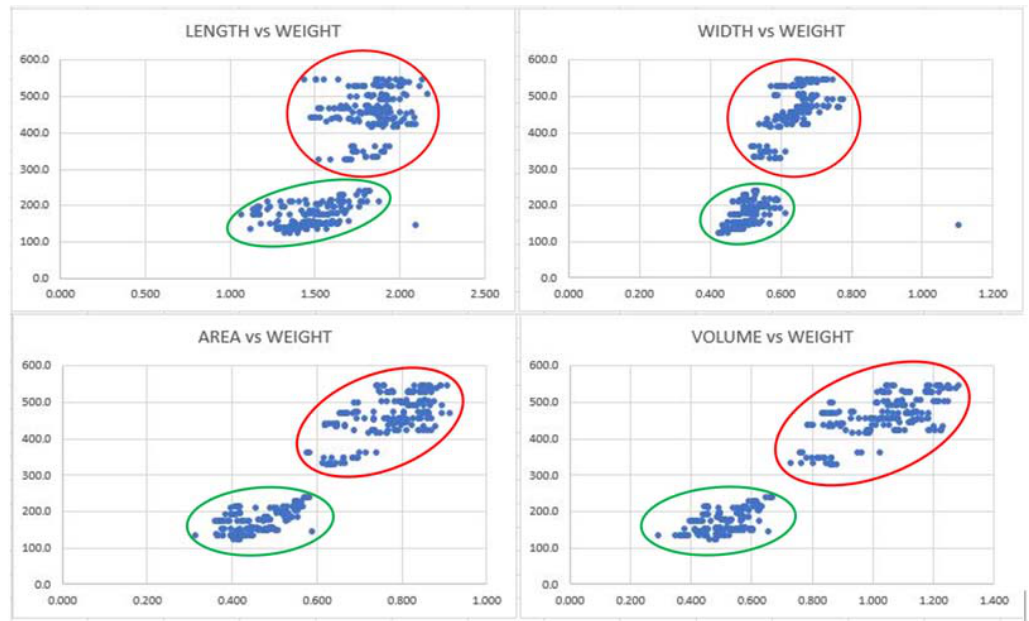
Figure 14. Scatter plot of the relationship between the four body characteristics and the cattle weight: red circle is male; green circle is female.